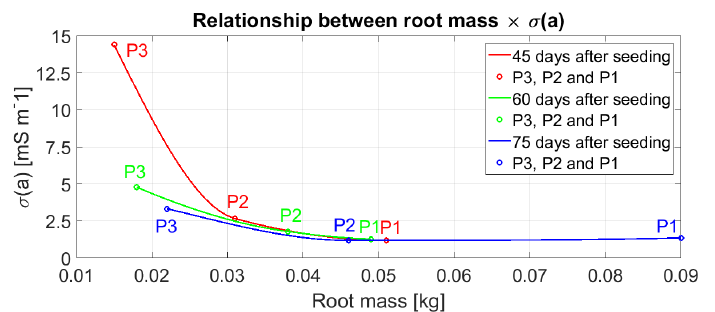
Figure 16. Relationship between σ a